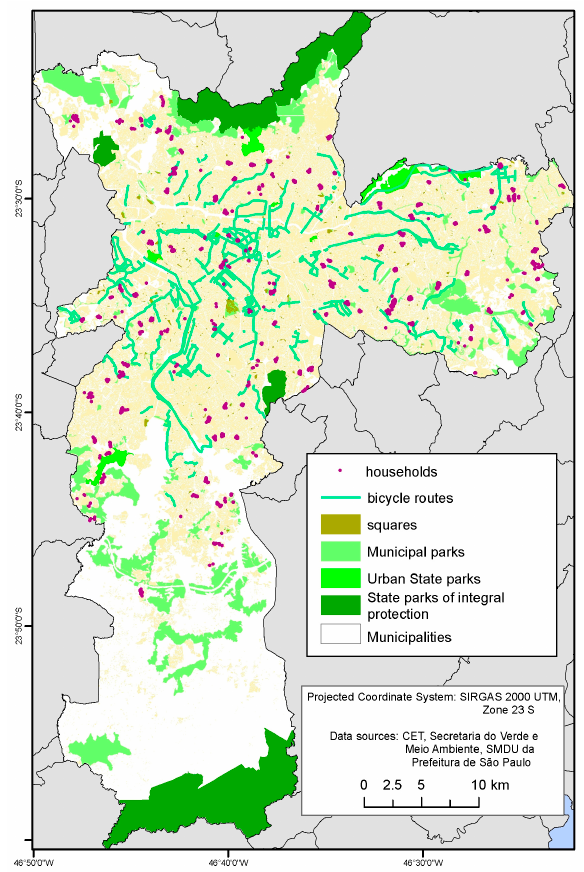
Figure 1. Public open spaces and households with interviews in Sao Paulo Health Survey, Sao Paulo,